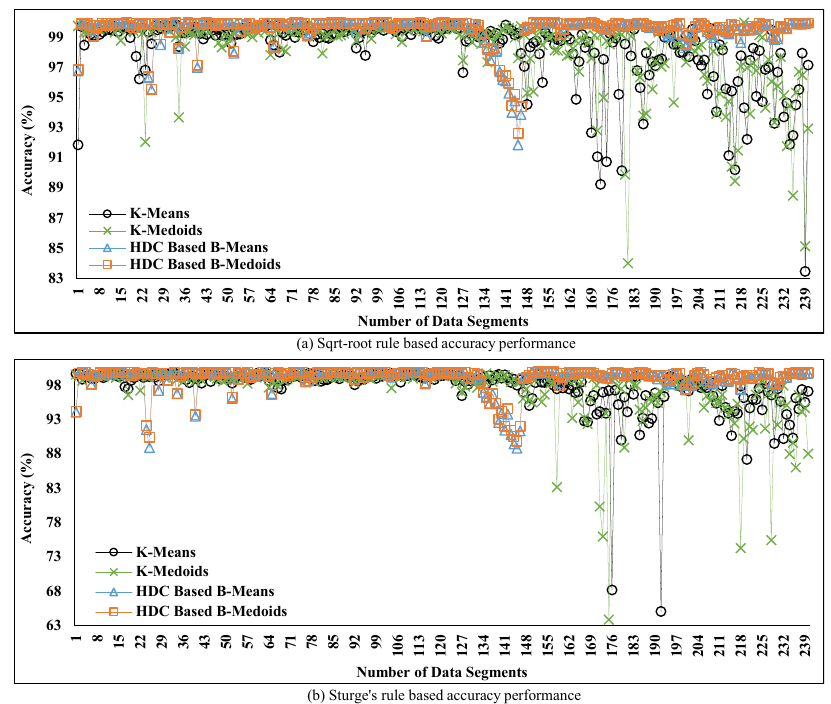
Figure 11. Performance comparison of proposed B-means and B-medoids with conventional K-means and K-medoids versus the number of data segments. ( a ) Accuracy versus square-root rule (K = 11); ( b ) accuracy versus Sturge’s rule (K =